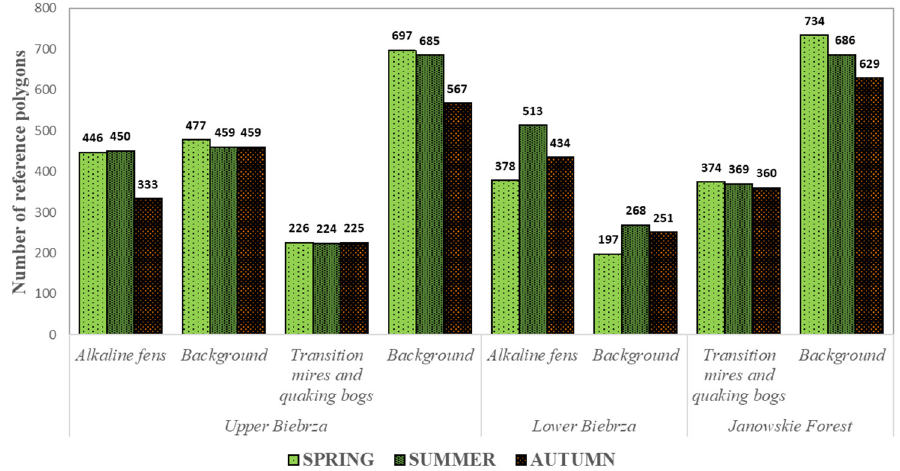
Figure 3. The number of reference botanical data (polygons) per research area (UB—Upper Biebrza, LB—Lower Biebrza, JF—Janowskie Forest).